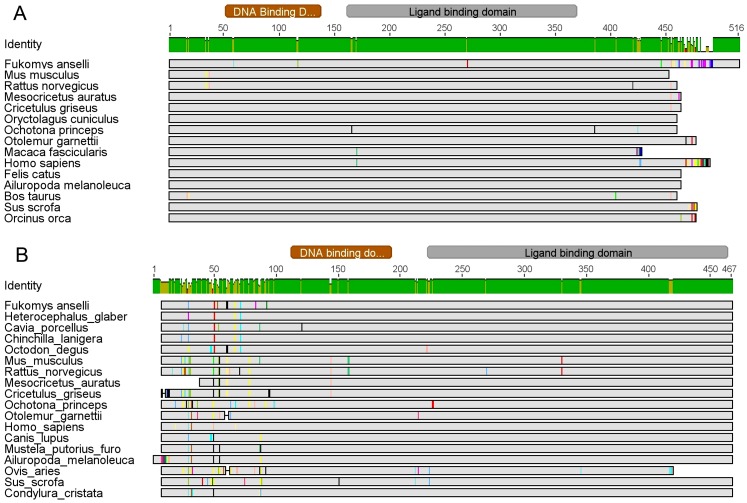
Protein sequence alignment for (A) TH receptor α (THRA) and (B) TH receptor β (THRB) of different mammalian species.
F. anselli mRNA sequences were derived from RNA-seq and subsequently translated, the other sequences were retrieved from NCBI databases (accession numbers are given in Figures S1 and S2). Sequence differences are marked in gray. “Identity” shows the percentage of amino acid conformity for each position; the protein domain regions correspond to the human sequence entry. A fully resolved representation of the alignment is given as a supplement (Figures S1 and S2).